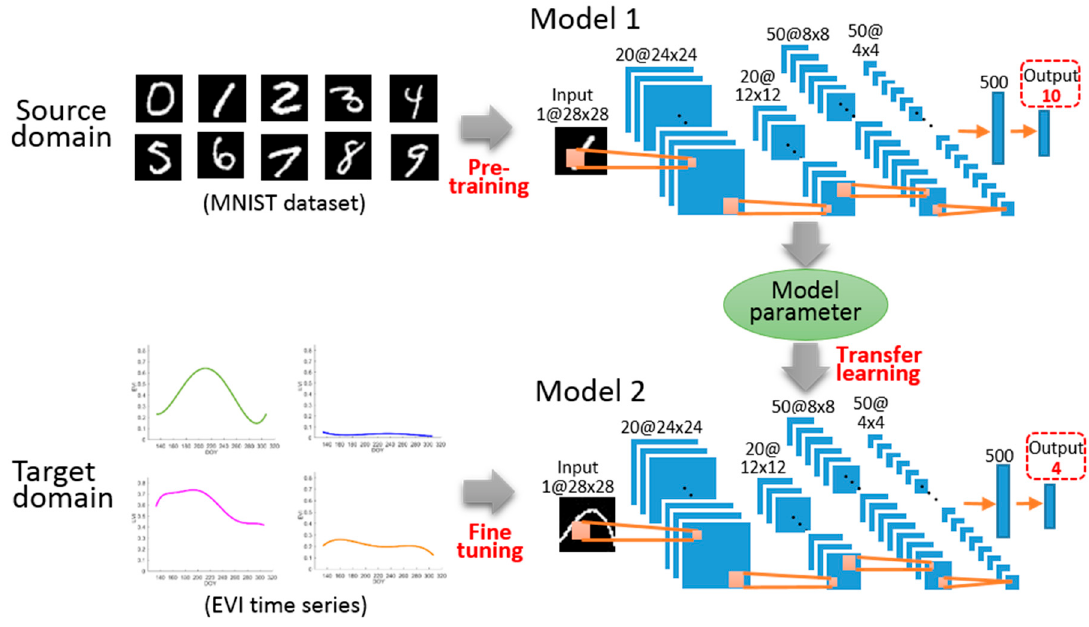
Figure 6. Procedure of transfer learning.